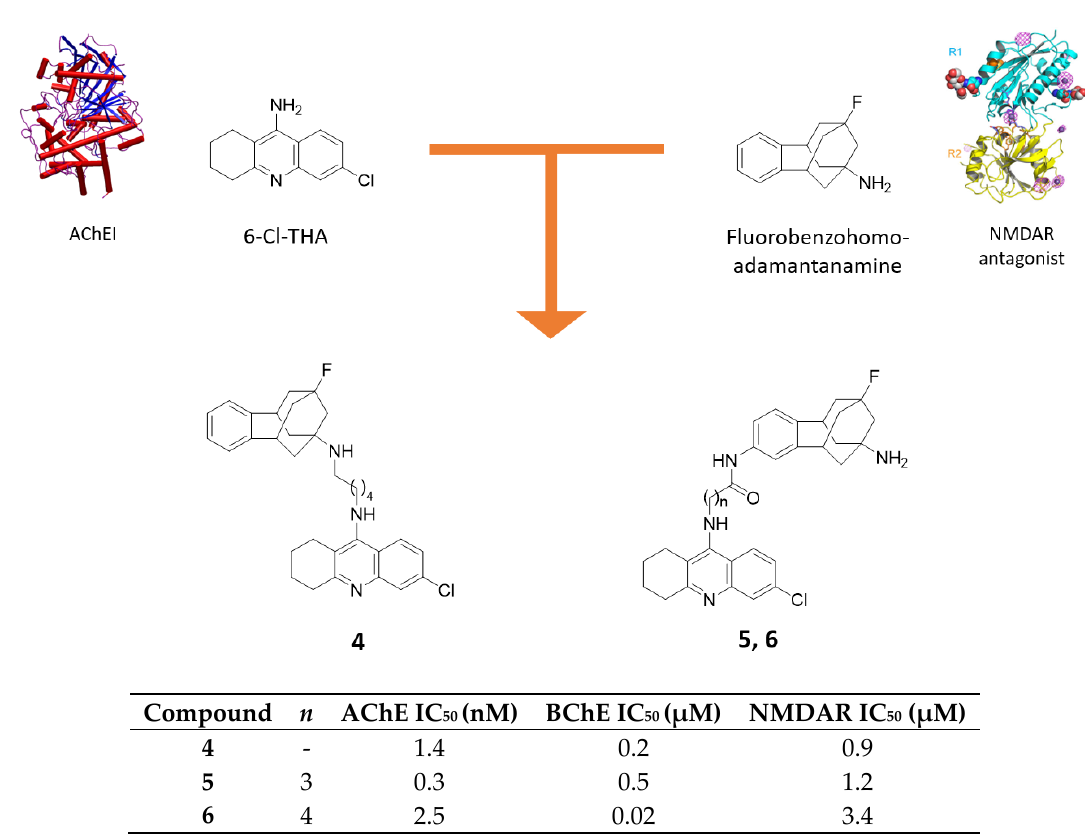
Figure 4. Drug design and biological activities of 6-chlorotacrine-benzohomoadamantane hybrids 4 – 6 .